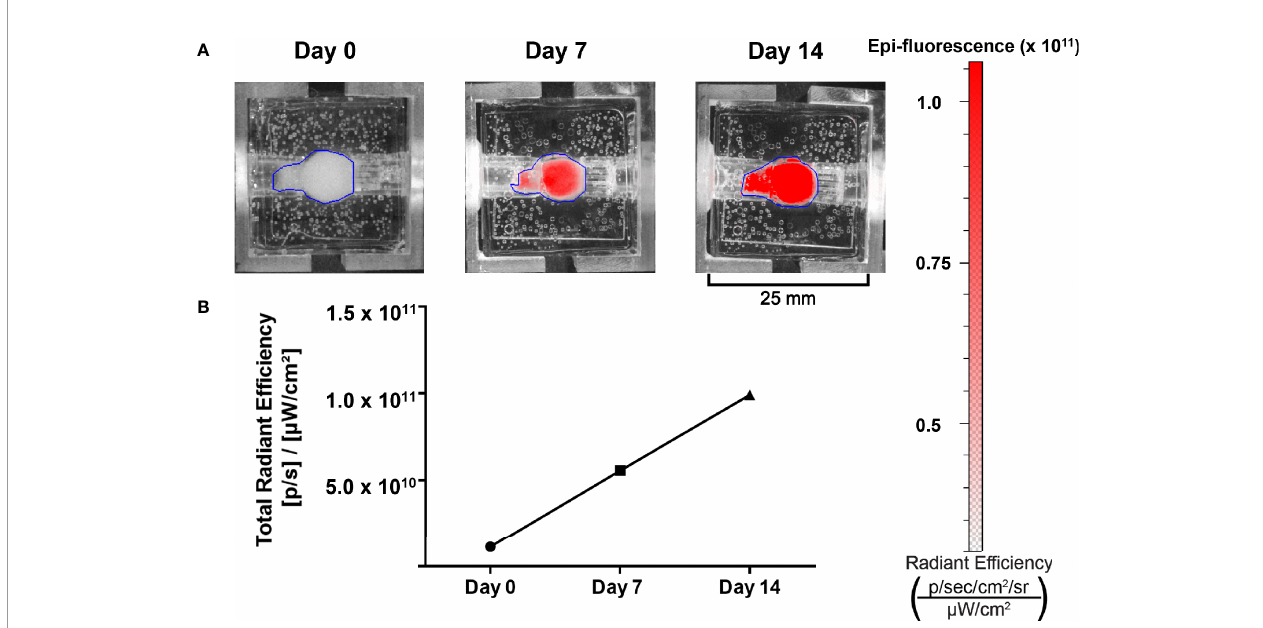
FIGURE 7 | Growth of NET cell lines within the bioreactor system can be observed using spectral reporters. (A) IVIS imaging of surrogates containing TT-RFP cells at days 0, 7, and 14. (B) Region of interest measurement of fl uorescent signals shows an increase between days 0 and